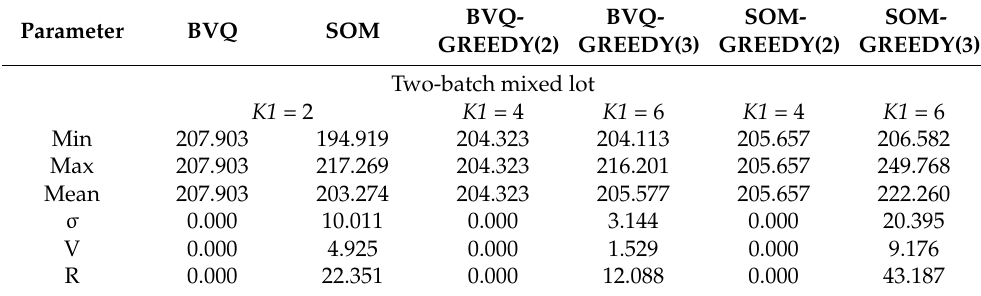
Table A1. Objective function value summarized after 30 attempts (Chebyshev distance, initialization by